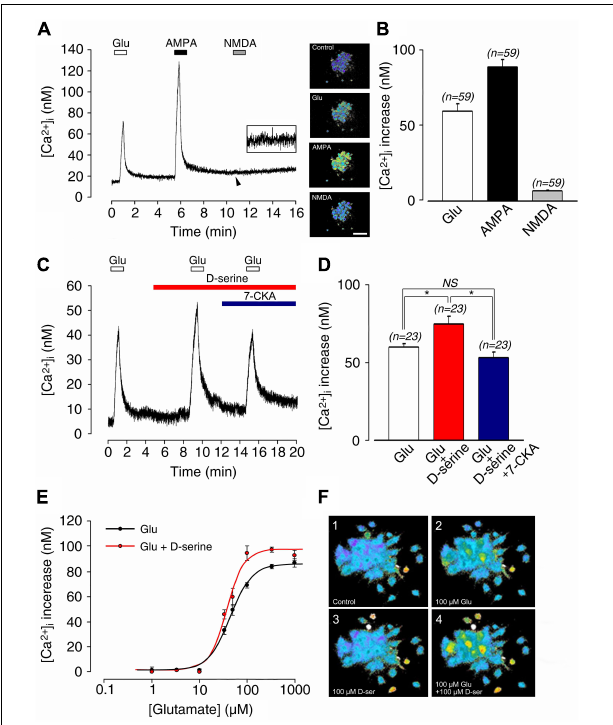
FIGURE 5 | (A) Postnatal 1–4 day-old rat spiral ganglion neuron (SGN) somata loaded with Fura-2 AM during sequential pharmacological stimulation with lock buffer containing either 100 µ M glutamate, 100 µ M AMPA, or 100 µ M NMDA. Right inserts: representative images of Fura-2 AM-loaded SGNs before (control condition) and during bath application of glutamate, AMPA, and NMDA. (B) Histograms summarizing changes in [Ca 2 + ] i after stimulation with glutamate (100 µ M; n = 59), AMPA (100 µ M; n = 59), and NMDA (100 µ M; n = 59). (C) 100 µ M D -serine potentiated glutamate-induced [Ca 2 + ] i increases ( n = 23). This effect was blocked by adding the selective antagonist of the glycine site of NMDAR 7-CKA (50 µ M; n = 23) to the bath solution. (D) Histograms summarizing changes in [Ca 2 + ] i after sequential stimulation with 100 µ M glutamate alone ( n = 23), 100 µ M glutamate plus 100 µ M D -serine ( n = 23), and 100 µ M glutamate plus 100 µ M D -serine in presence of 50 µ M 7-CKA ( n = 23). (E) Dose-response curve showing the excitatory effects of bath application of 100 µ M D -serine on glutamate-induced [Ca 2 + ] i (glutamate concentration ranging from 1 to 1,000 µ M). The calculated EC 50 for glutamate was reduced from 45.8 µ M in the absence, to 35.6 µ M in the presence of D -serine ( n = 212). (F) Typical calcium images showing a group of SGNs before (control condition; 1), at the maximum response to 100 µ M glutamate (2), at rest in the presence of 100 µ M D -serine (3), and finally during the maximum response to 100 µ M glutamate plus 100 µ M D-serine (4). Inserts (A) Scale bar:100 µ m. (n) number of neurons, *( p < 0.05), (NS) (not significant).